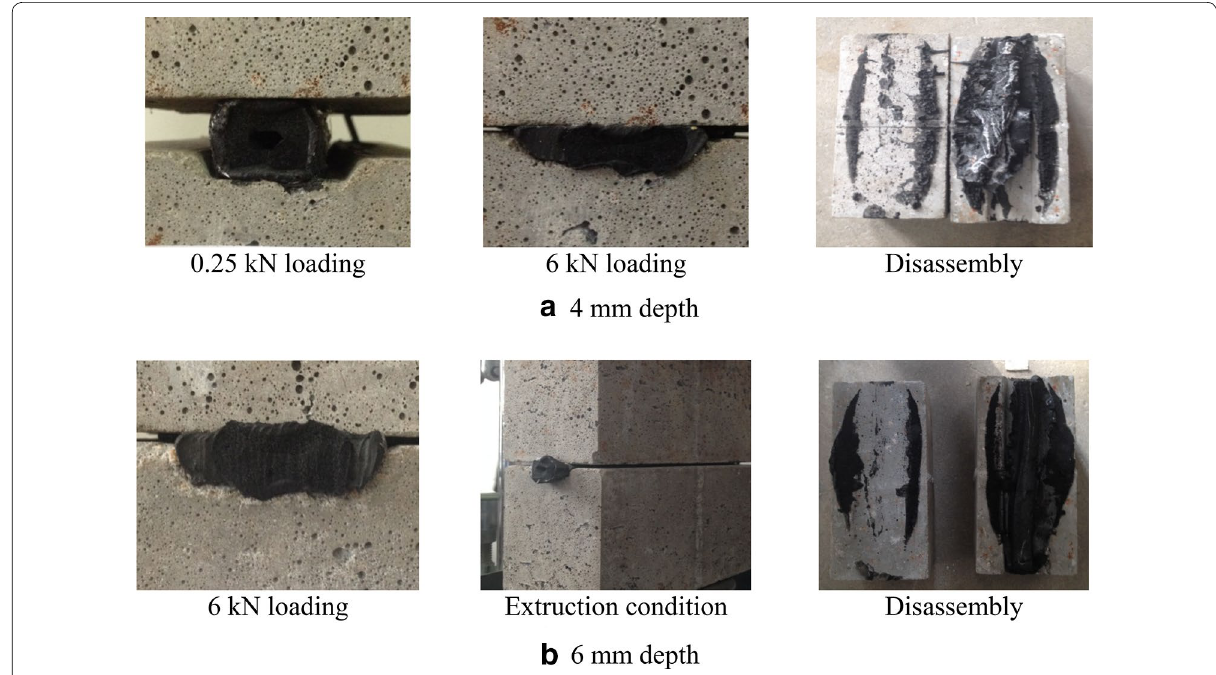
Fig. 8 Waterproofing tests: a 4 mm depth; and b 6 mm